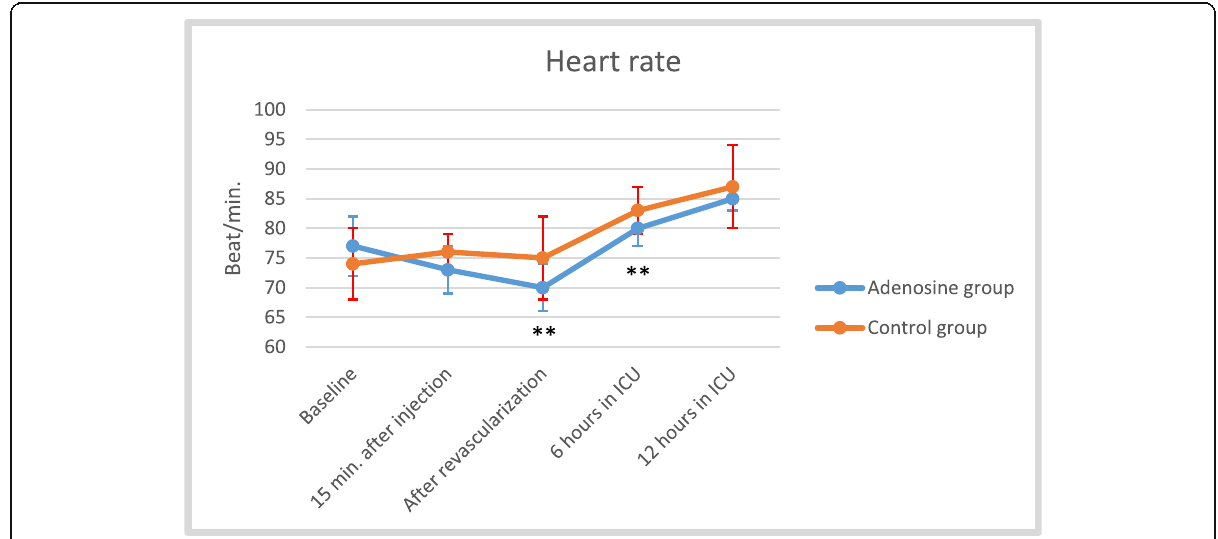
Fig. 1 Effect of adenosine on heart rate. Data were presented as mean ± SD. ** p value is highly